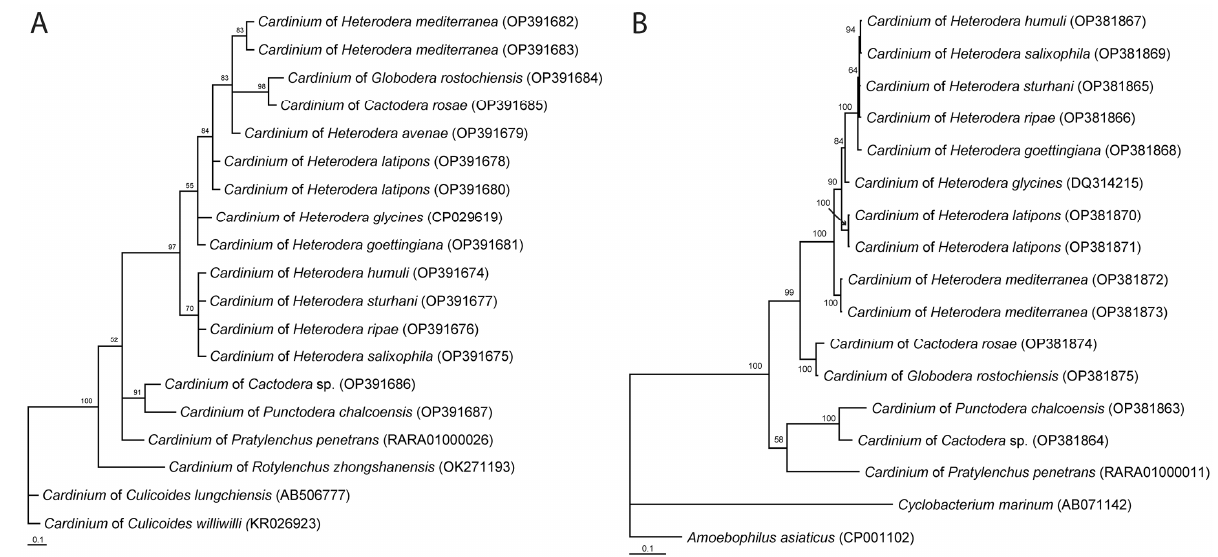
Figure 1. Phylogenetic relationships among representatives of Cardinium clade found in plant- parasitic nematodes. Bayesian 50% majority rule consensus tree as inferred from the 16S rRNA gene sequence alignment (alignment length-443 bp) ( A ) and the gyrB gene sequence alignment (alignment length-662 bp) ( B ) under the GTR + I + G model. Posterior probabilities (BI) more than 50% are shown at branching points.